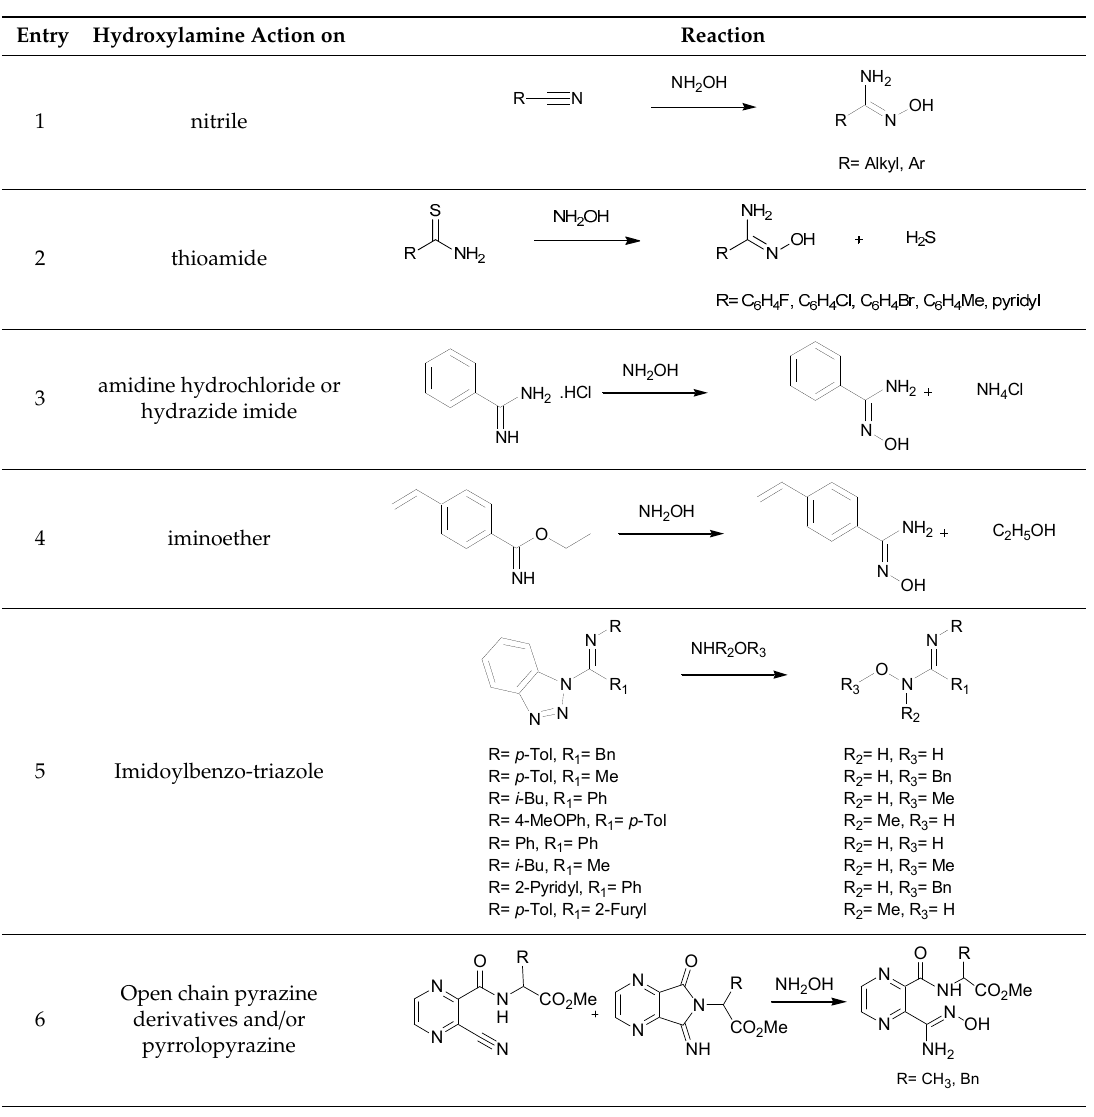
Table 3. Reaction of ammonia and amines with oximinoethers and hydroximic acid chlorides.